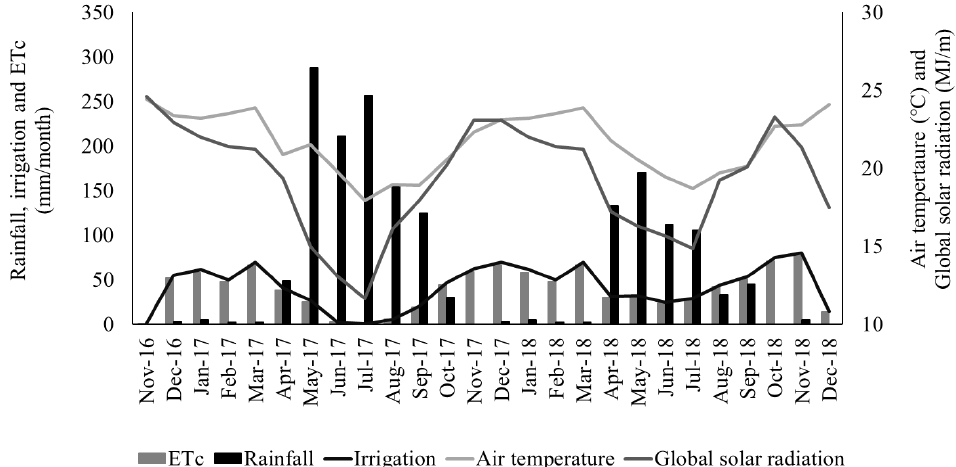
Figure 1. Rainfall, crop evapotranspiration (ETc), daily irrigation, air temperature, and global solar radiation recorded during the experimental period at Garanhuns, Pernambuco, Brazil.